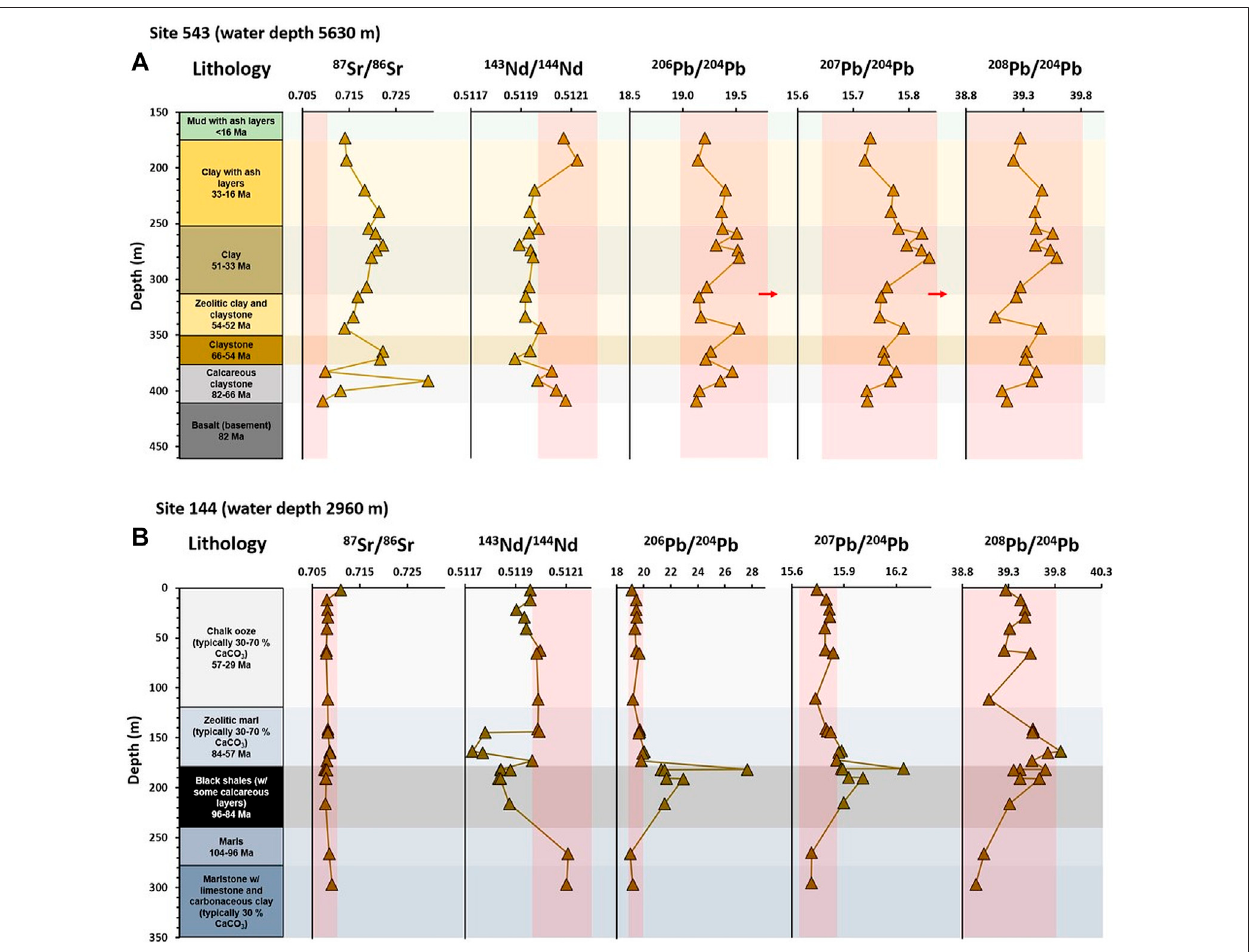
FIGURE 9 | (A): Radiogenic isotopic compositions of DSDP Site 543 sediments, modi fi ed from Carpentier et al. (2008). (B): Radiogenic isotopic compositions of DSDPSite144sediments,modi fi edfromCarpentieretal.(2008).PinkbarindicatesisotopicrangeofMartiniquelavas(datasourcesasper Figure8 ).Foralldatapoints, uncertainty (2 SE) is smaller than symbol size. Red arrows in (A) indicate that range of lavas exceeds the scale shown on the plot.